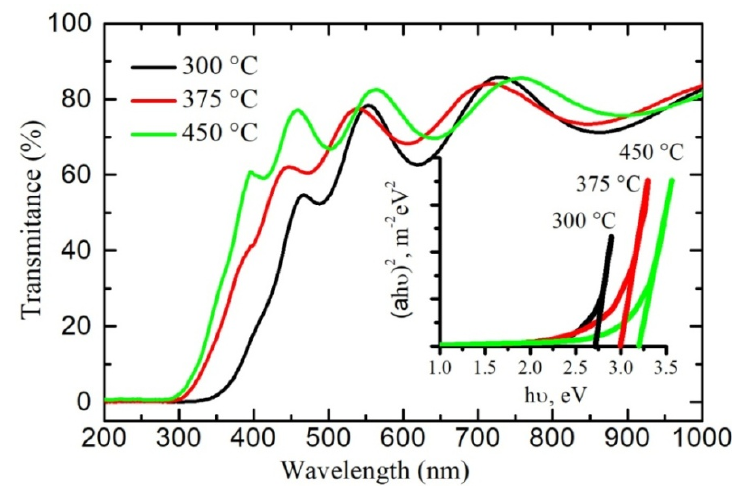
Figure 3. Optical transmission spectra of the SnO 2 − δ films. Inset shows the dependence of the parameter ( α h ν ) 2 on photon energy h ν , where α is the adsorption coefficient.